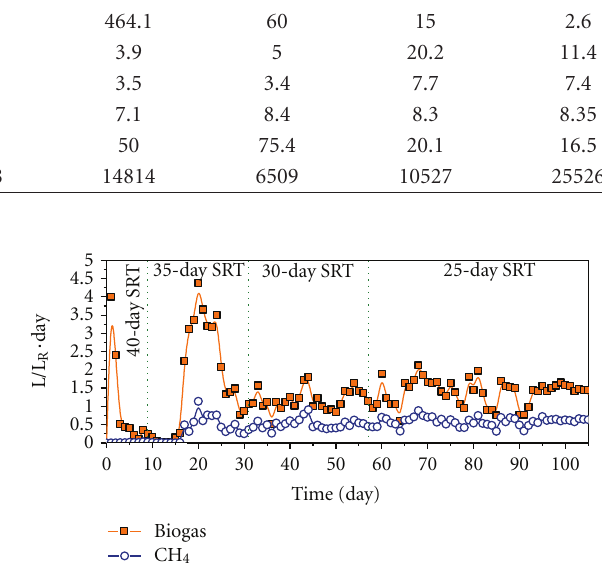
Figure 4: Daily biogas and methane productions expressed as